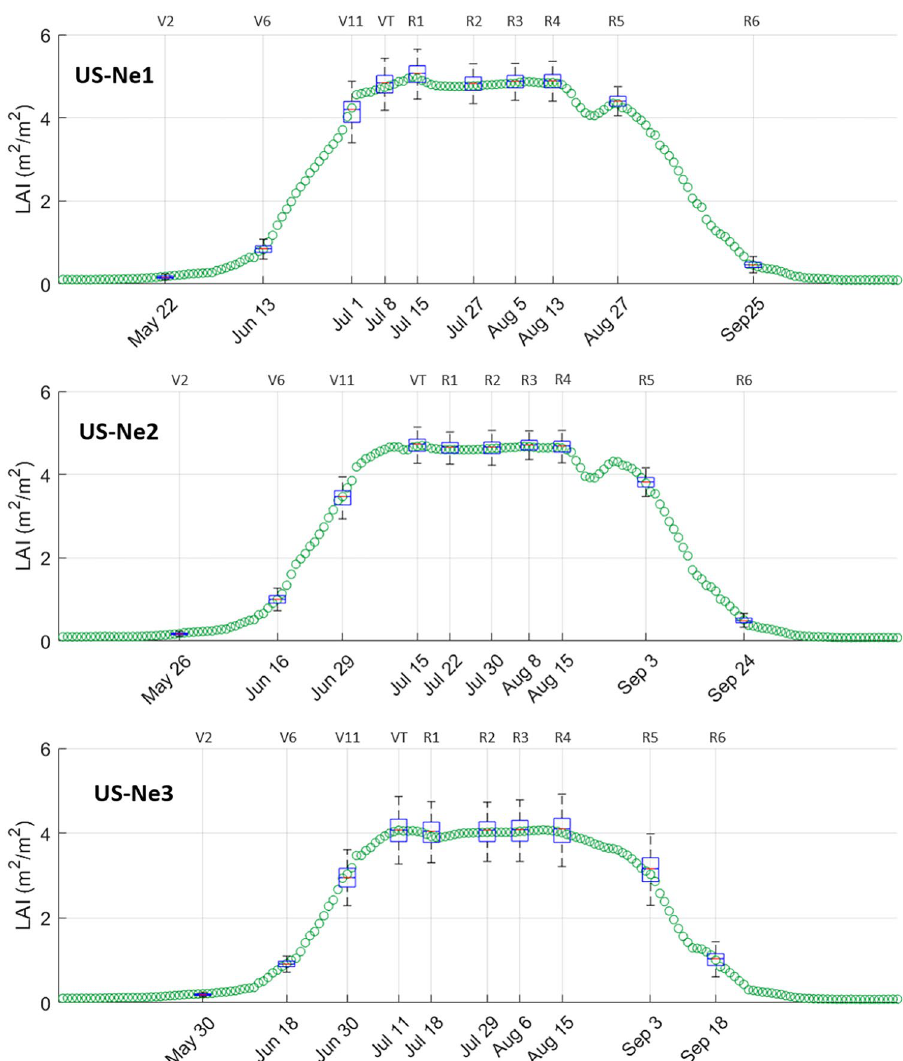
Figure 5. Box-and-whisker plots showing the field-identified stages of the 2nd (V2), 6th (V6) and 11th (V11) leaf collar, tasseling (VT), and the six reproductive stages, representing silking (R1), blister (R2), milk (R3), dough (R4), dent (R5) and maturity (R6). Boxes: interquartile range (IQR); lower limit of boxes: first quartile (Q1); upper limit of boxes: third quartile (Q3); whiskers: Q1-1.5(IQR) and Q3 + 1.5(IQR); line through boxes: median. All outliers were removed for visual clarity. Each green circle represents the average daily CubeSat- derived LAI per field during the growing